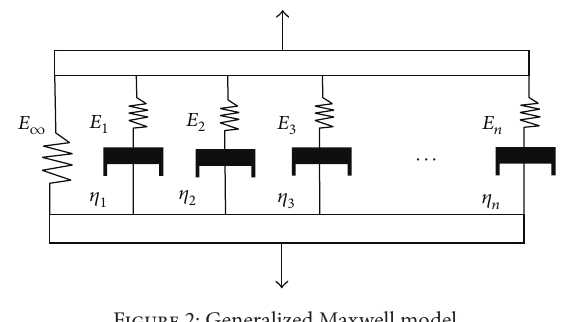
Figure 2: Generalized Maxwell model.